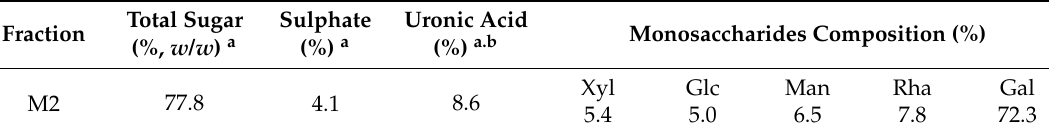
Table 4. Chemical analysis of M2 of MEP.